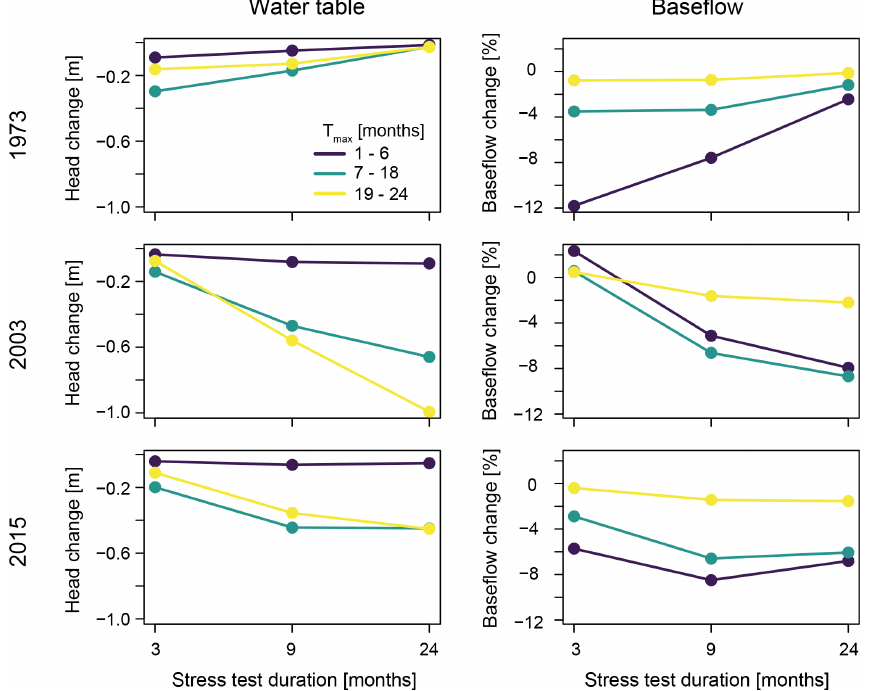
Figure 8. Effects of S EVENT with T RP = 50 years for three different classes of T max averaged over Germany. Note the different scales for the y